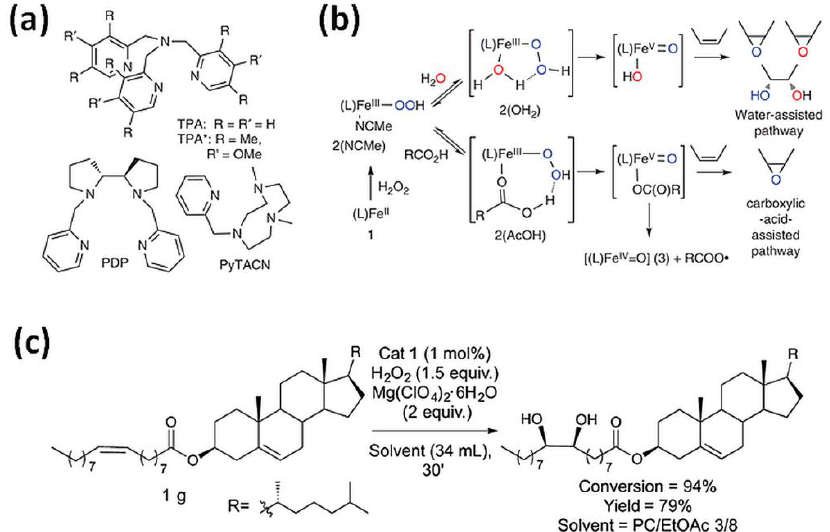
Figure 2. ( a ) Tetradentate ligands in bio-inspired non-heme iron-mediated olefin oxidations; ( b ) Activation of H 2 O 2 by non-heme iron oxidation catalysts with the assistance of water or carboxylic acids with TPMA- (1–3) and TPMA*-based (1 *–3 *) complexes [6]. Reprinted with permission from Nature Publishing Group, a division of Macmillan Publishers Limited, Copyright 2014. ( c ) Gram-scale syn- dihydroxylation of cholesteryl oleate catalyzed by tips3 TPMA (1) with H 2 O 2 as oxidant [4]. Reprinted with permission from American Chemical Society, Copyright 2018.